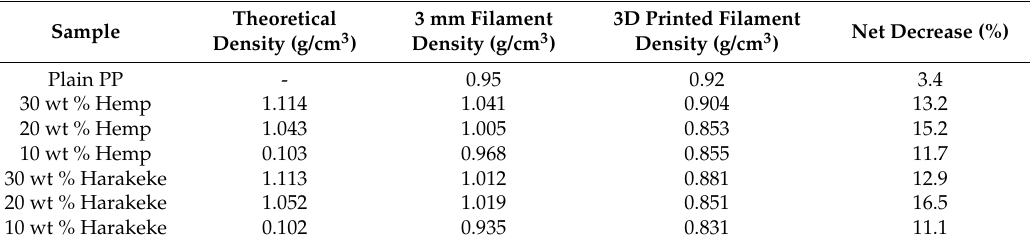
Table 1. Density of 3 mm printing filament compared to 1 mm printed